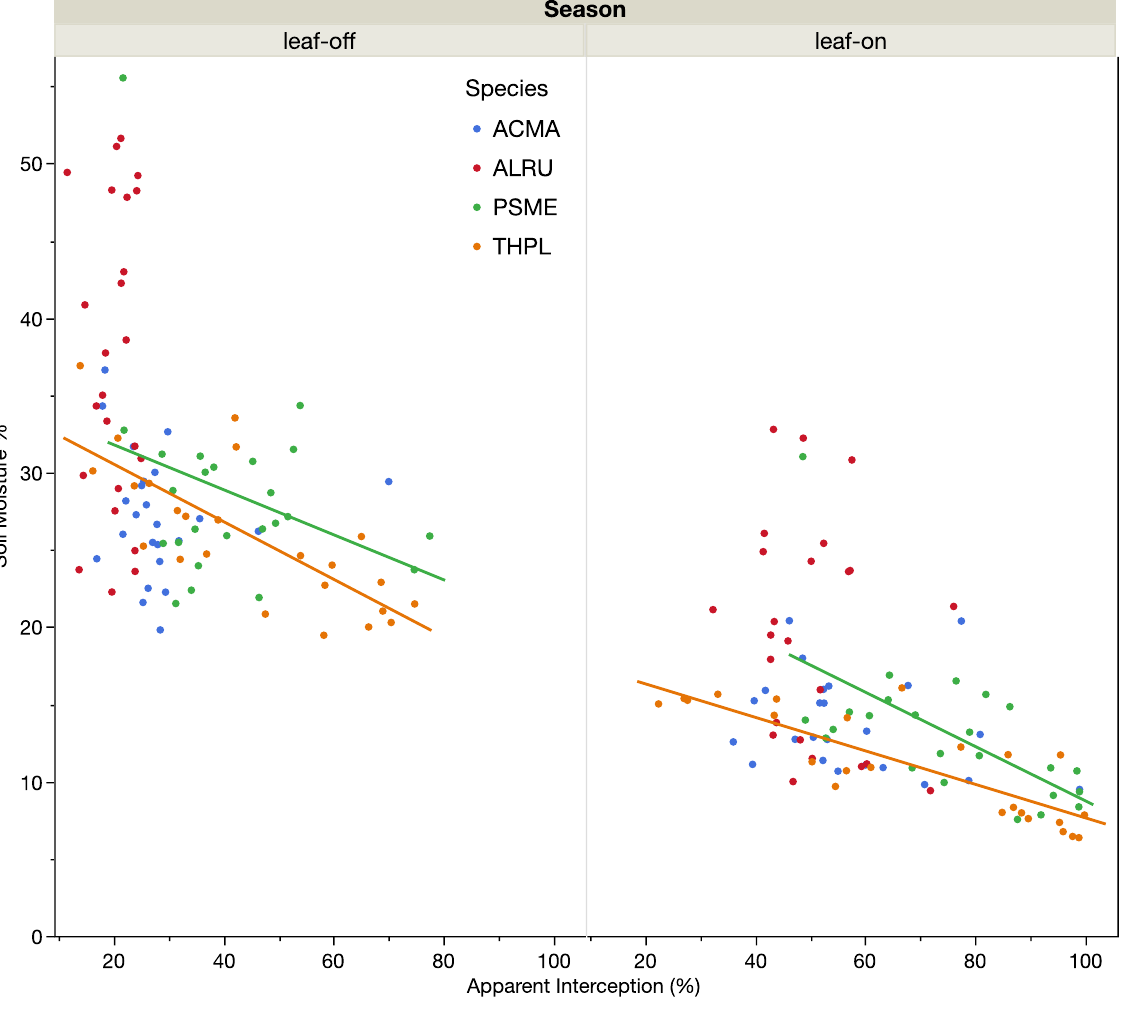
Figure 4. Linear regression relationships between apparent canopy interception (%) and soil moisture (%) in the leaf-off period (left panel) and the leaf-on period (right panel). Species codons in the legend refer to A. macrophyllum (ACMA), A. rubra (ALRU), P. menziesii (PSME), and T. plicata (THPL). Significant relationships within leaf-off and leaf-on periods were only present for the two conifer species (leaf-off: P. menziesii R 2 = 0.22, p = 0.02, T. plicata R 2 = 0.58, p < 0.001; leaf-on: P. menziesii : R 2 = 0.35, p = 0.001, T. plicata R 2 = 0.69, p < 0.001). All species showed significant relationships when both periods were pooled ( p < 0.05).